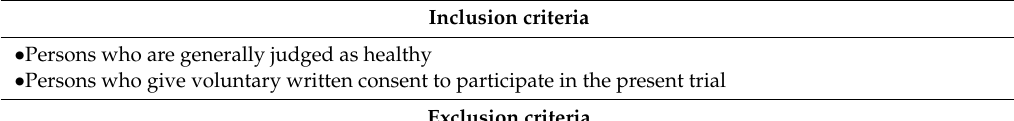
Table 1. Inclusion and exclusion